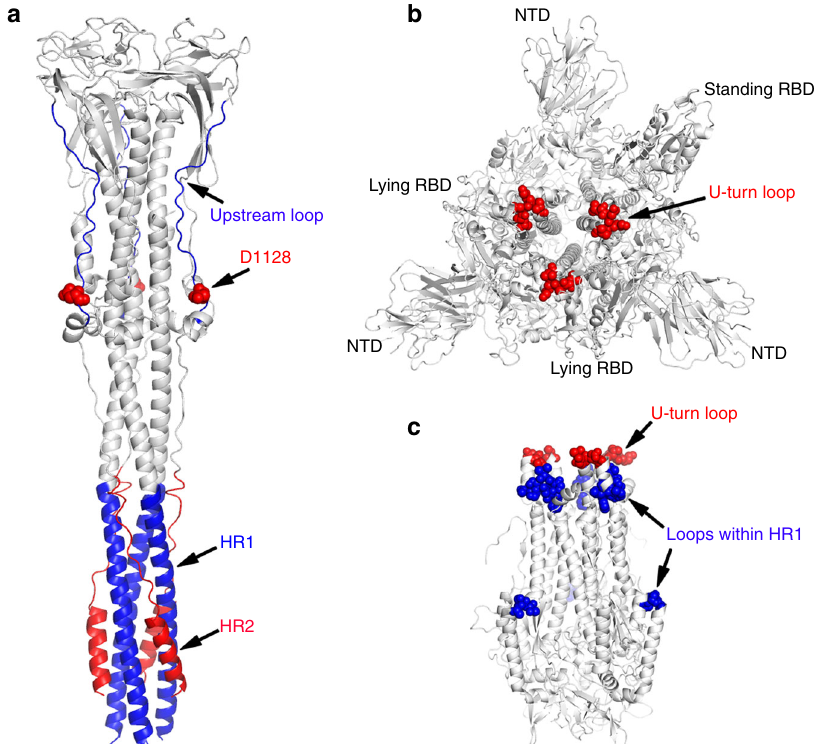
Fig. 6 Potential therapeutic targets within SARS-CoV S2 subunit. a Cartoon representation of the linker loop region upstream of the HR2 motif (blue loop), the HR1 motif (blue helix) and the HR2 motif (red). The residue D1128 is shown as spheres colored in red. b The U-turn loop connecting the HR1 and CH motif in the pre-fusion SARS-CoV S trimer 27 (PDB: 5X 5B). The pre-fusion SARS-CoV structure is shown as cartoons colored in white. The U-turn loop is presented as spheres colored in red. c The U-turn loop and other loop regions within the HR1 and CH motifs in the pre-fusion S2 subunit 27 (PDB: 5X 5B). The U-turn loop is shown as spheres colored in red and the other loop regions are shown as spheres colored in